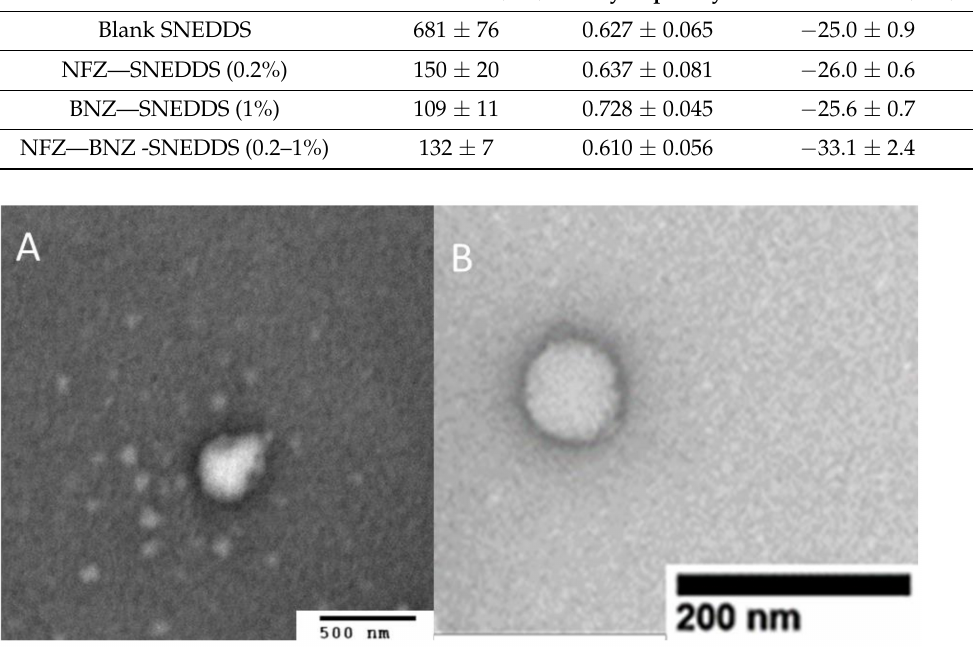
Figure 3. TEM images of aqueous dispersions of NFX-BNZ-SNEDDS ( A , B ) (1 in 400 w / w ) stained with 1% uranyl acetate. Bars: 500 and 200 nm respectively.